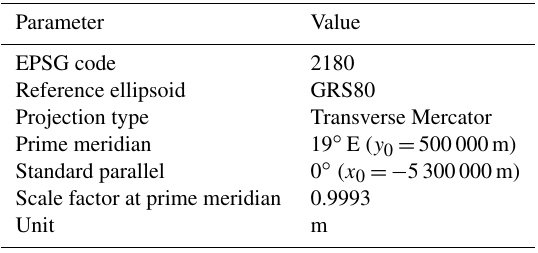
Table 1. Details of EPSG:2180 coordinate system.